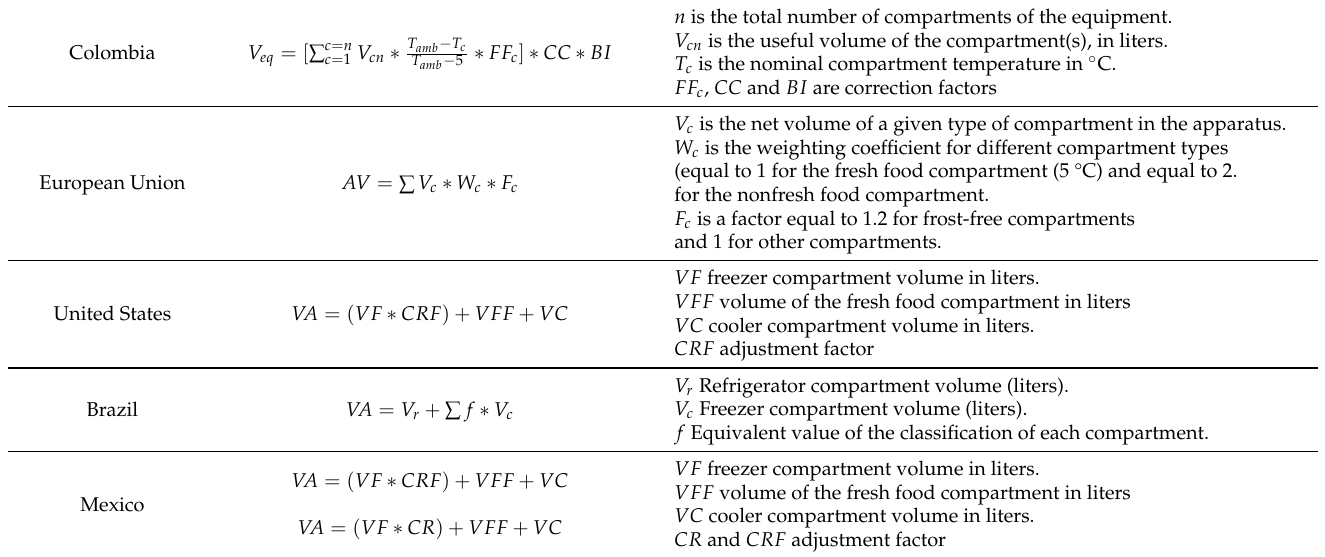
Table 7. Calculation of Adjusted Volume in Colombia, EU, US, Brazil and Mexico.